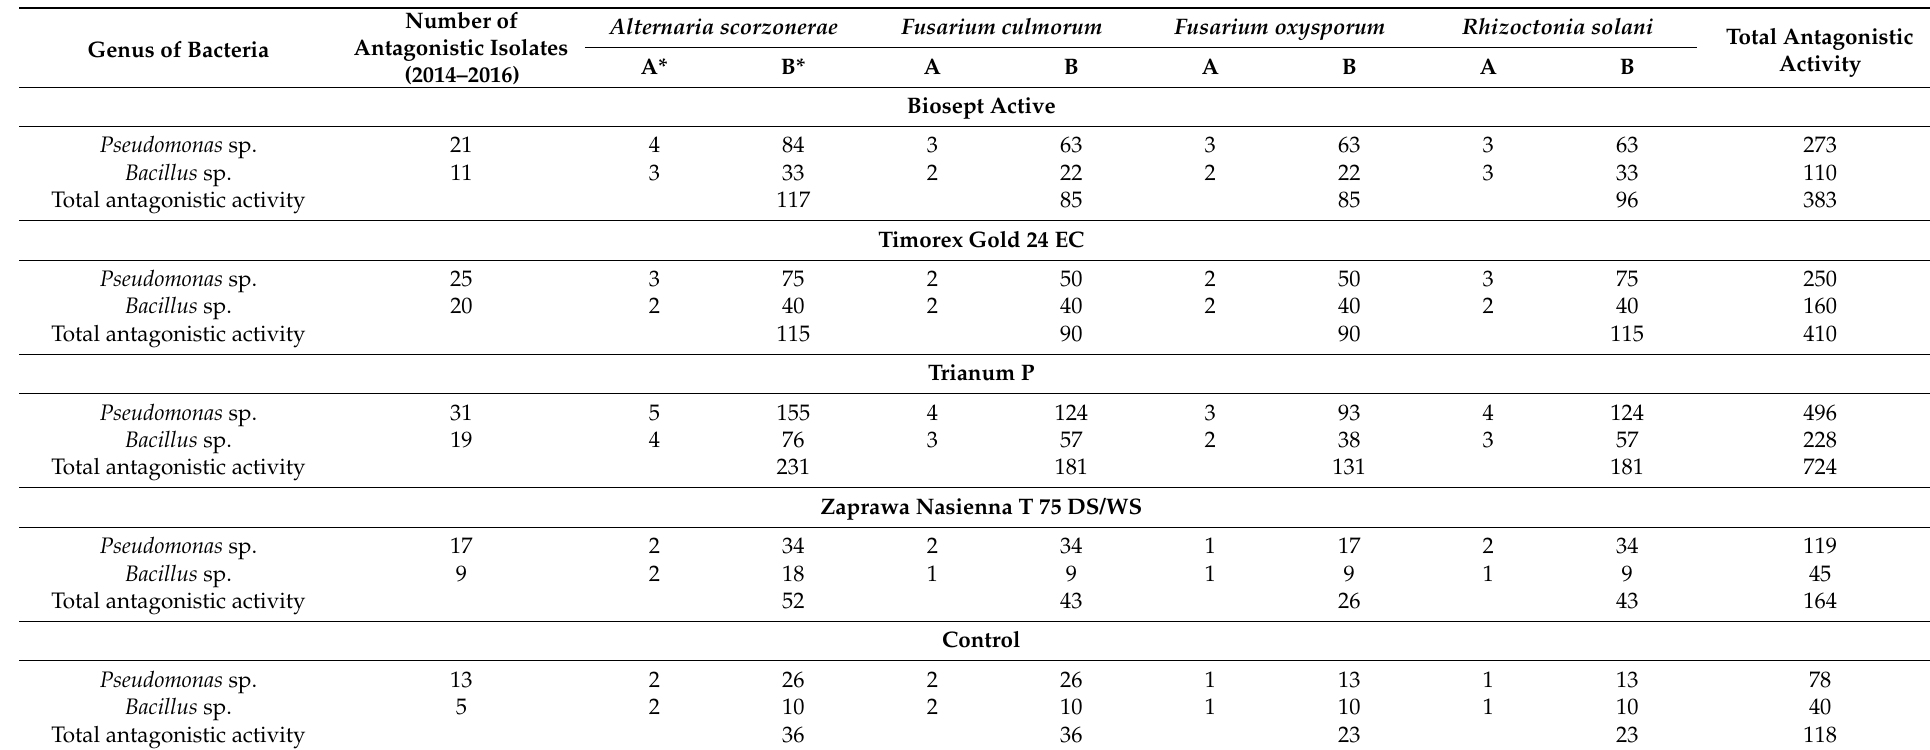
Table 7. Antagonistic activity of bacteria isolated from the scorzonera rhizosphere towards pathogenic fungi. Genus of Bacteria